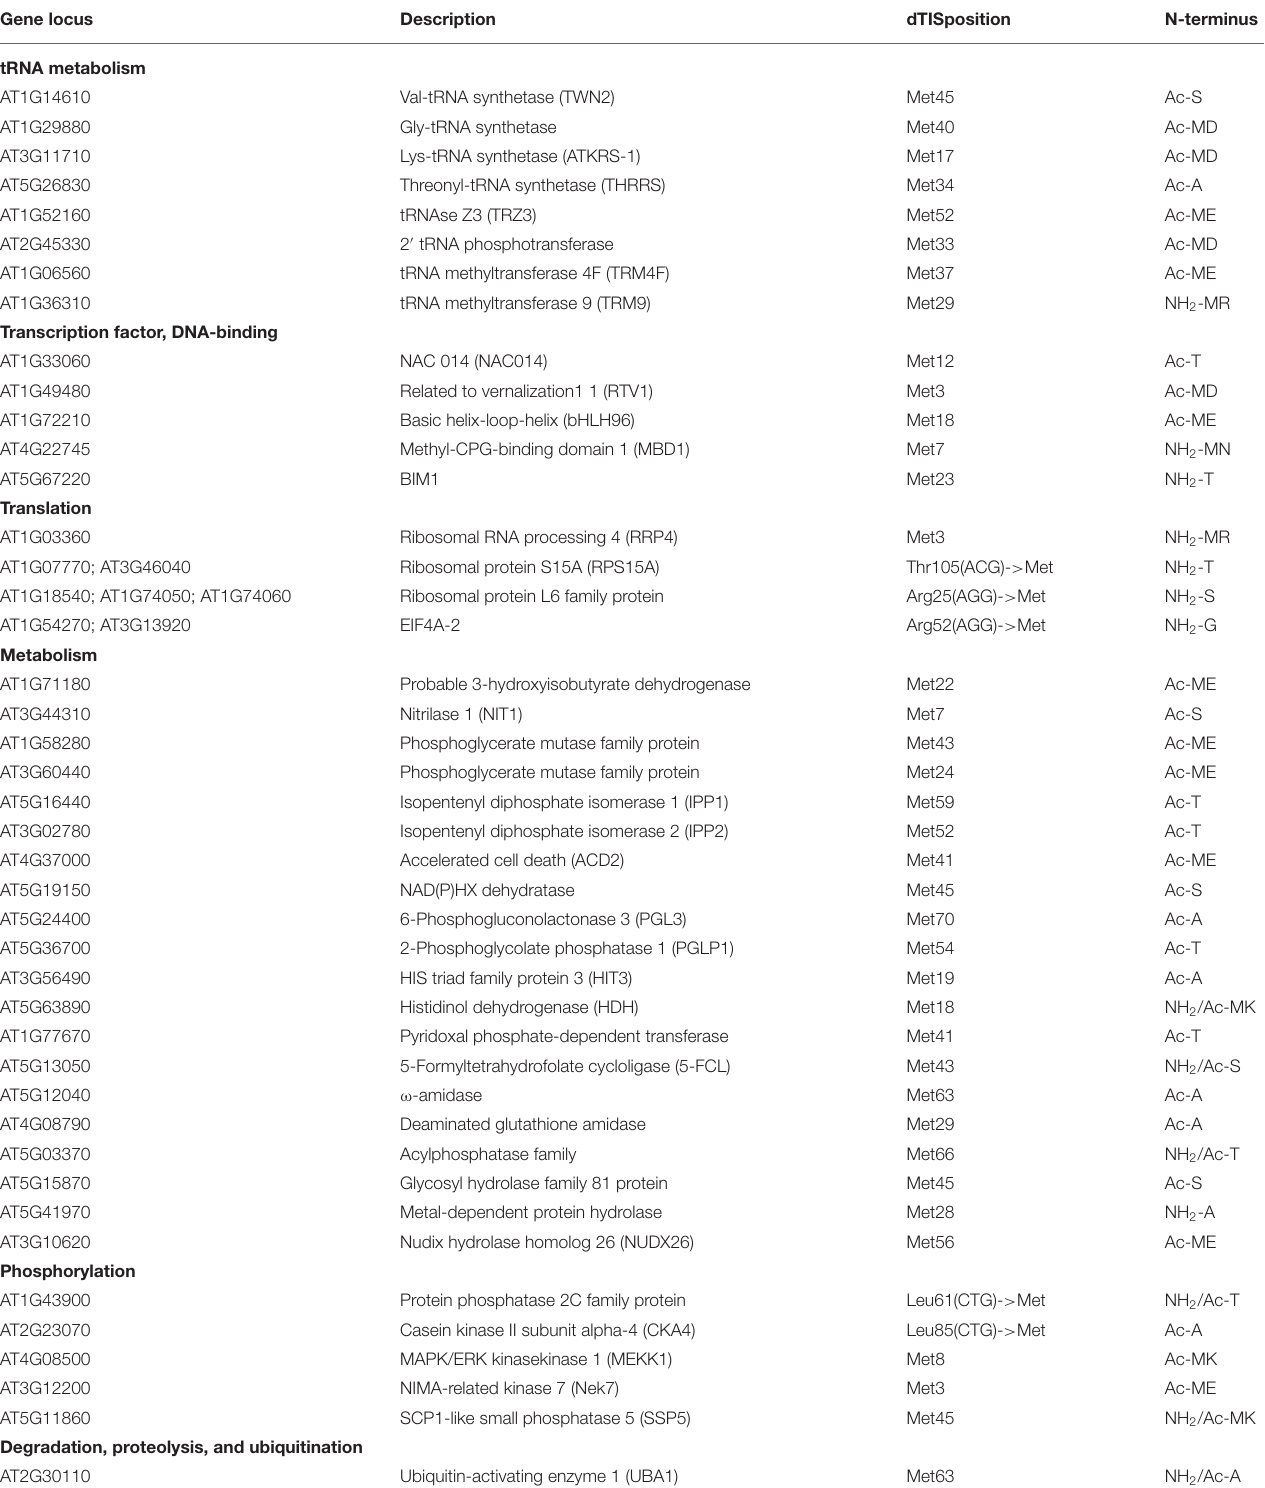
TABLE 1 | List of 68 N-terminal (Nt)-truncated proteoforms with matching riboproteogenomics evidence shaped by downstream alternative translation initiation sites (dTISs). Gene